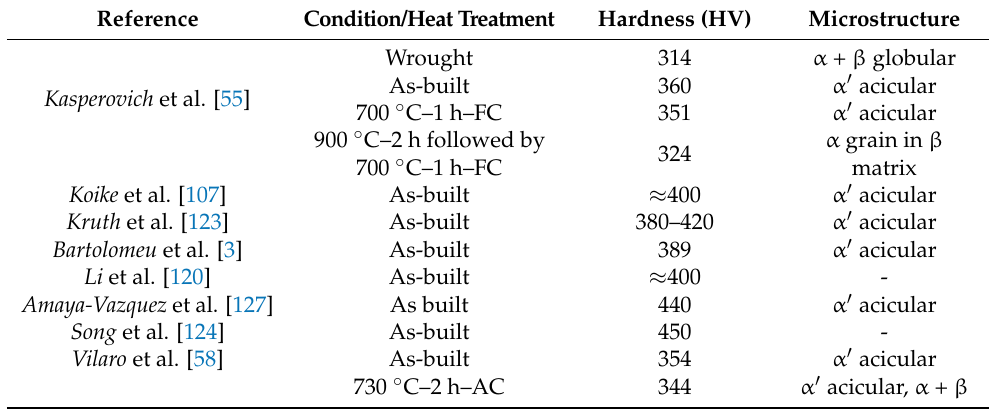
Table 6. Summary of LPBF Ti6Al4V hardness data extracted from